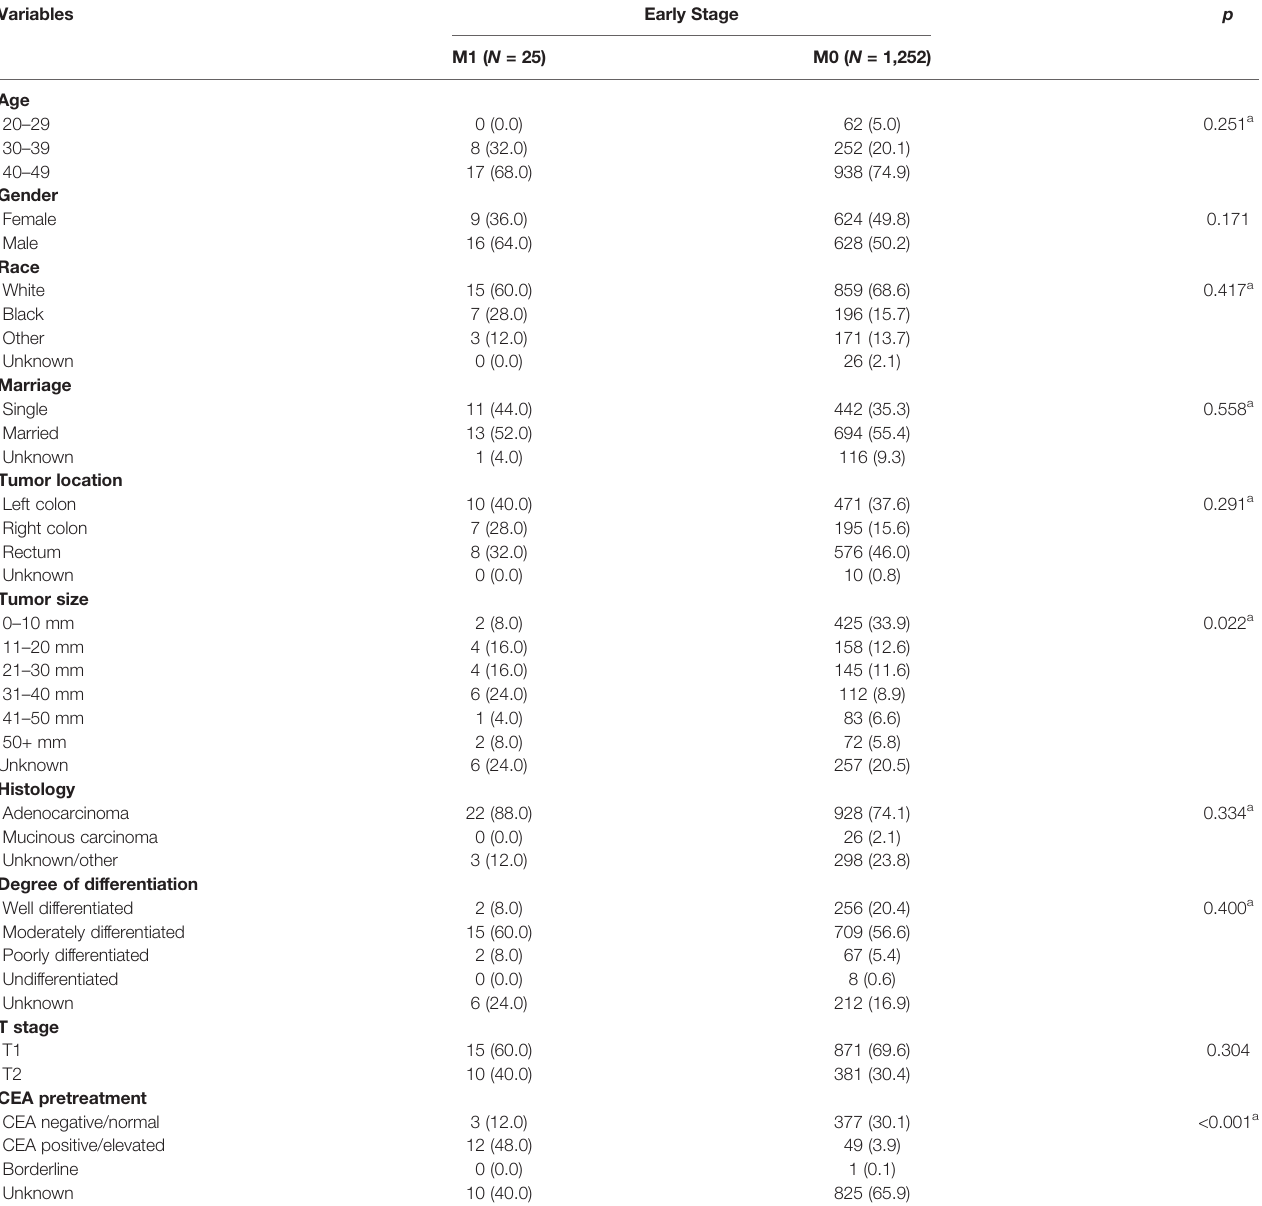
TABLE 4 | Risk factors associated with distant metastasis of young-onset colorectal cancer in early stage